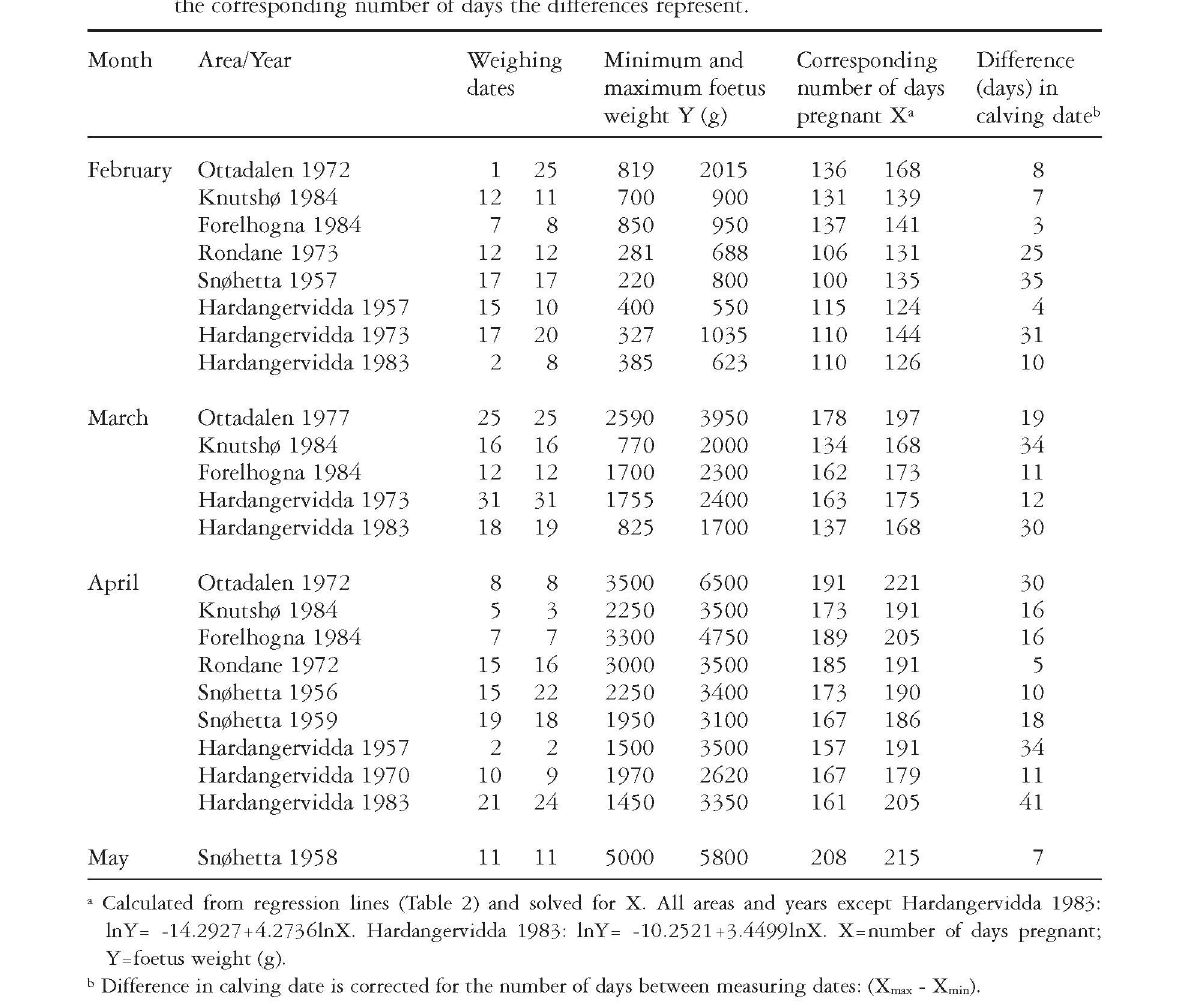
Table 4. Ln transformed regressions of foetus weights (Y) in g from pregnant females 2 1/2 yr + at concep¬ tion in relation to number of days pregnant (X) in Feb, Mar, Apr and May (211>X>85 days). Area and Year n Equation Estimated delay (days) in conception date among: Yearlings (» = 16) Calves (n=4) a LnY=-l2.2006 + 3.8960lnX 3, 7, 3, 31